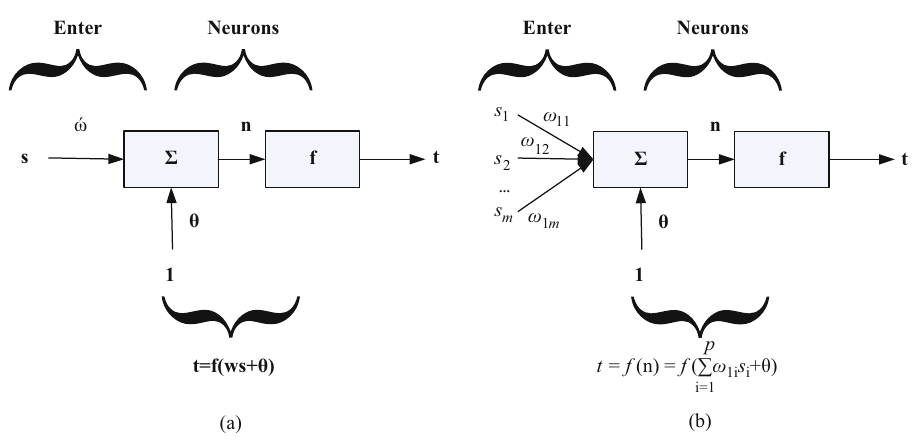
Figure 6: Neuron model. ( a ) Single - input neuron model; ( b ) neuron model with p input